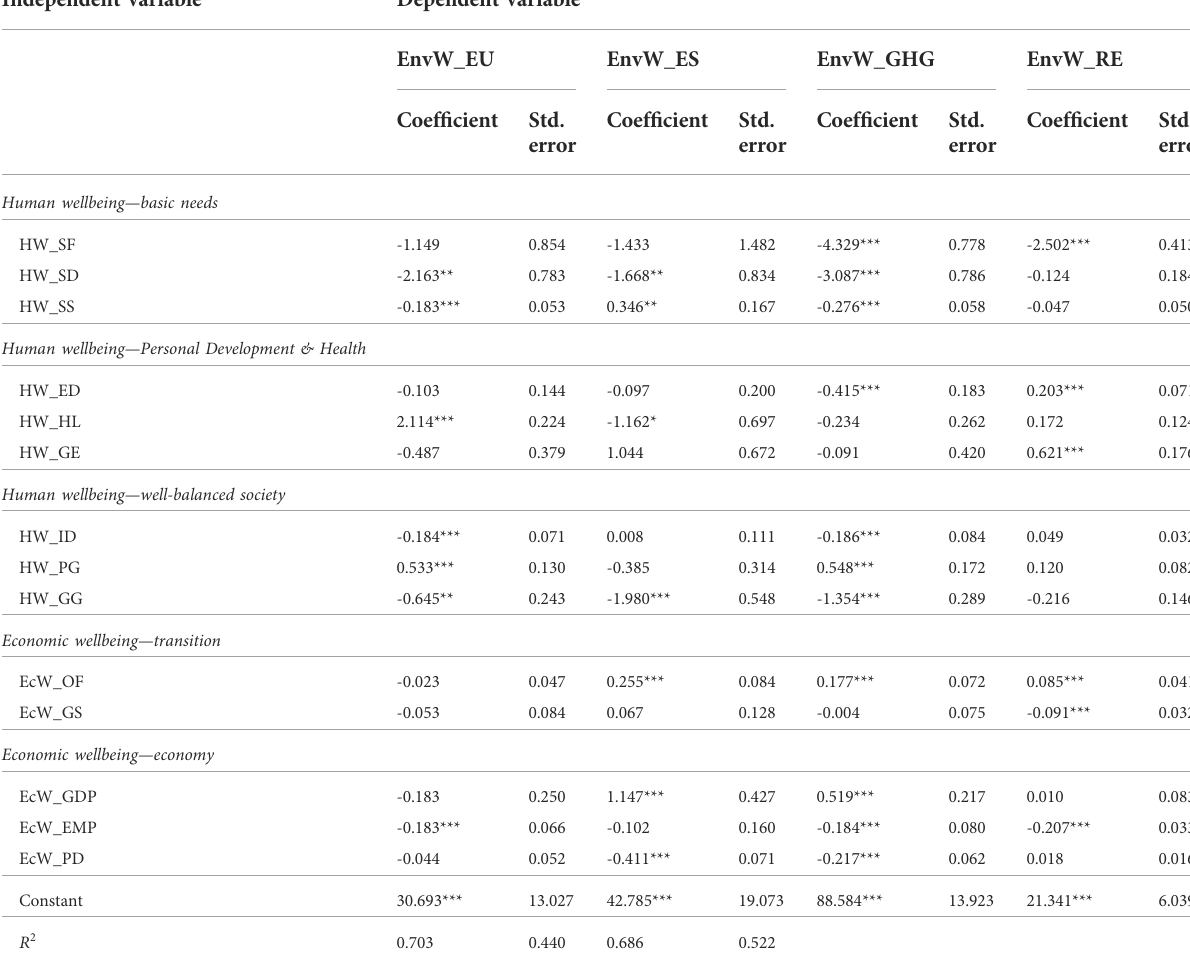
TABLE 4 Relation between the components of Climate and Energy from environmental wellbeing and components of economic and human wellbeing. Independent